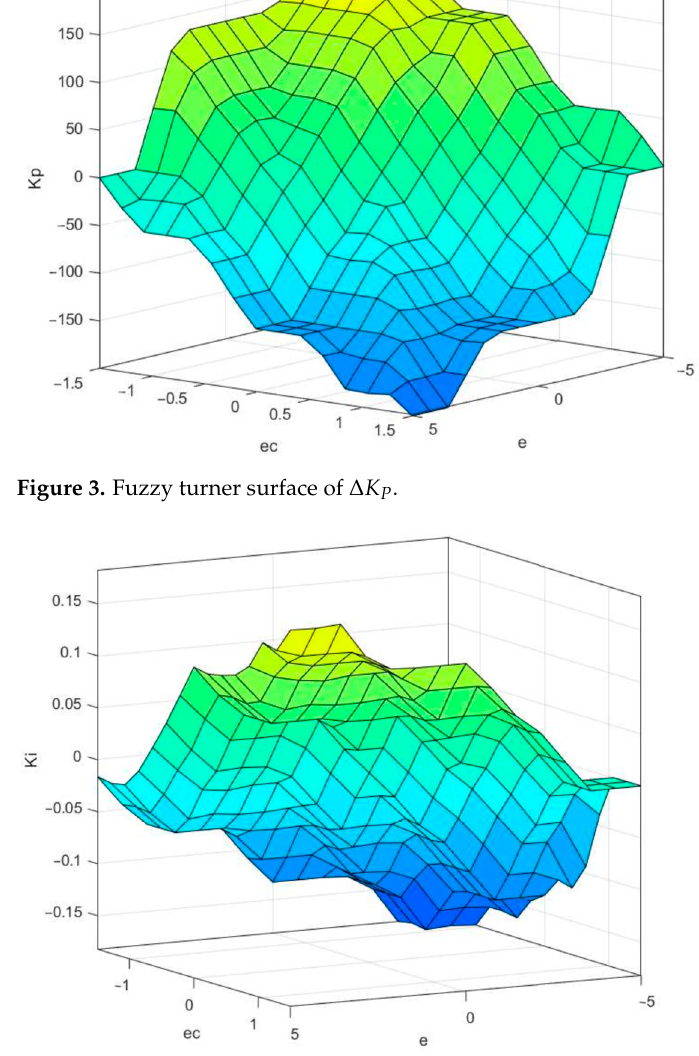
Figure 4. Fuzzy turner surface of ∆ K I . The equation above indicates that K P , K I and K D are the PID controller’s parameters that are adjusted in real time using the fuzzy control rules for the crane system. On the other hand, K P 0 , K I 0 and K D 0 represent the initial values of the PID controller’s parameters for the crane